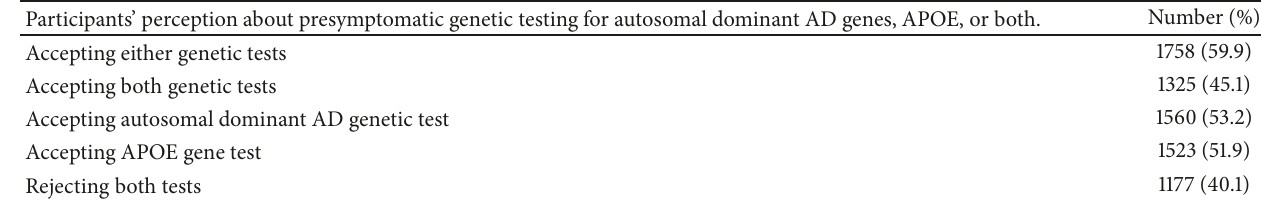
Table 3: Participants’ perception about presymptomatic genetic testing for Alzheimer’s disease (total number of participants =2935). Participants’ perception about presymptomatic genetic testing for autosomal dominant AD genes, APOE, or